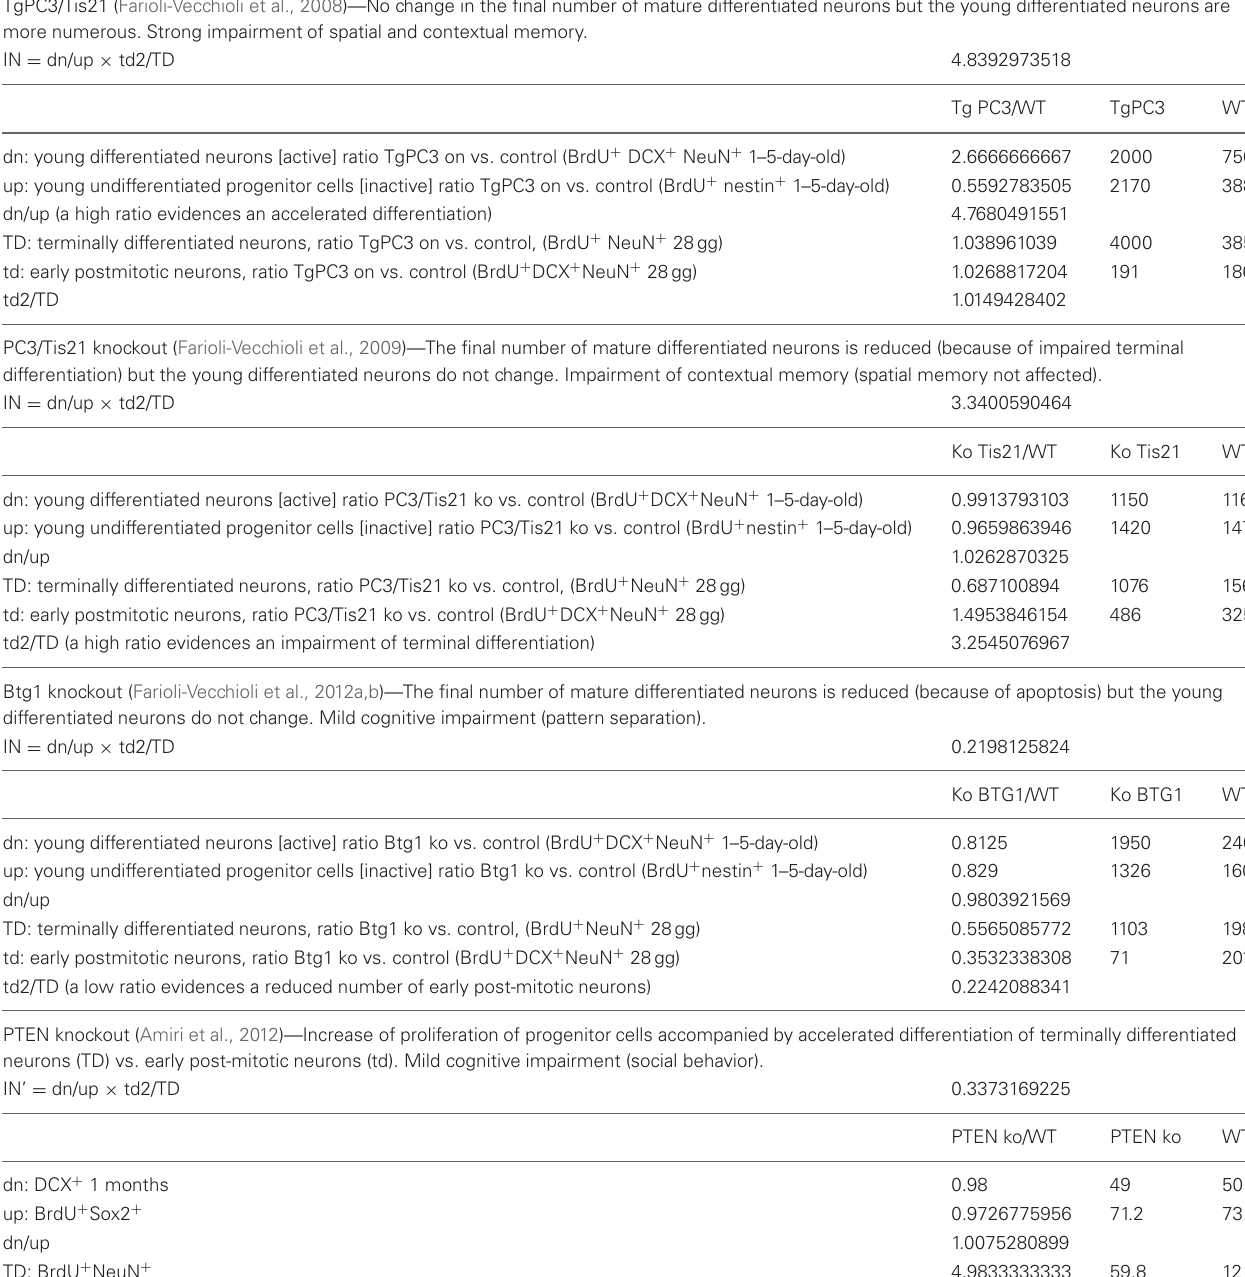
Table A1 | Index of neurogenesis (IN), based on differentiation and/or number ratios of mutant vs. wild-type progenitor cells and neurons. TgPC3/Tis21 (Farioli-Vecchioli et al., 2008)—No change in the final number of mature differentiated neurons but the young differentiated neurons are more numerous. Strong impairment of spatial and contextual